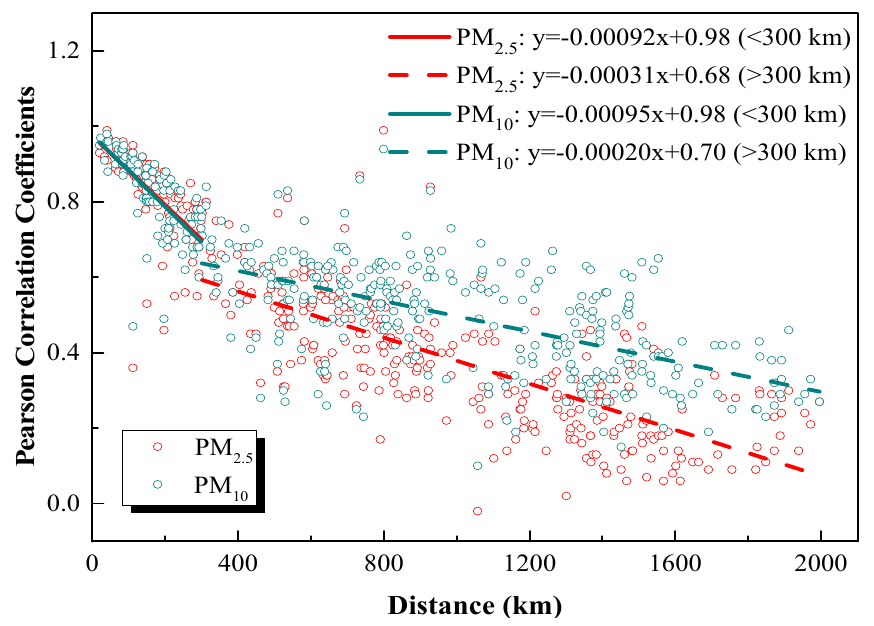
Figure 5. Pearson correlation coefficients of PM 2.5 and PM 10 between cities over the YREB.